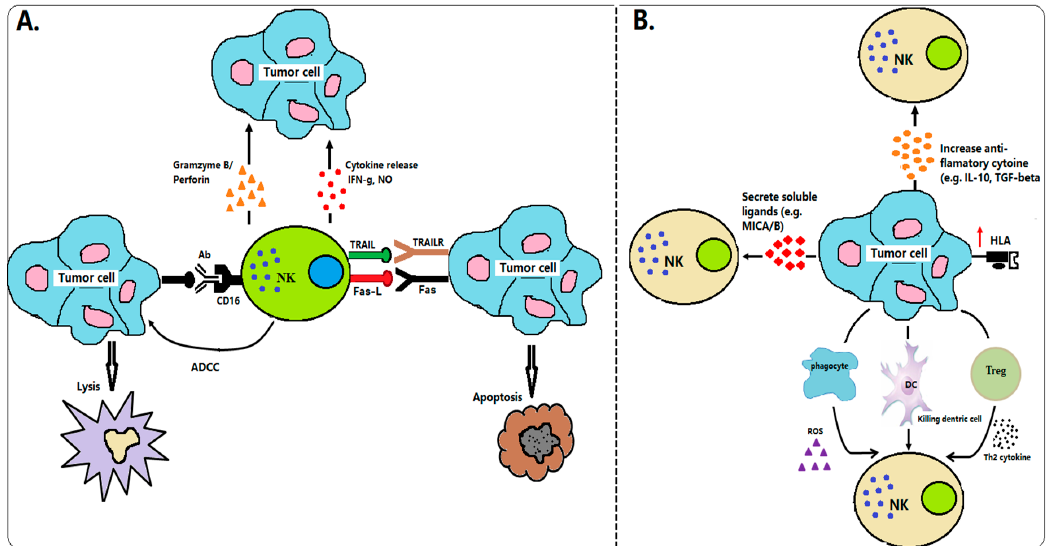
Figure 1. Interactions between NK cells and cancer cells in immunosurveillance. ( A ) Mechanism of NK cells in tumor immunosurveillance. NK cells can identify the tumor cells by stress or danger signals. Upon stimulation, NK cells directly killed tumor cells through many tactics, including the release of cytokine productions (e.g., IFN-g, NO), cytoplasmic gran- ule release (e.g., granzyme B, perforin), death receptor-induced apoptosis (e.g., Fas-L, TRAIL), and ADCC. ( B ) Mechanism of tumor cells invading NK cells. Tumor cells defend themselves from NK cell attack through several techniques, including secretion soluble ligand of NK cell receptors (e.g., MICA/B), upregulation of HLA molecules, secretion immunosuppres- sive factor products (e.g., TGF- β or IL-10), and activation of Treg or phagocyte-derived inhibitory cytokines (ROS).